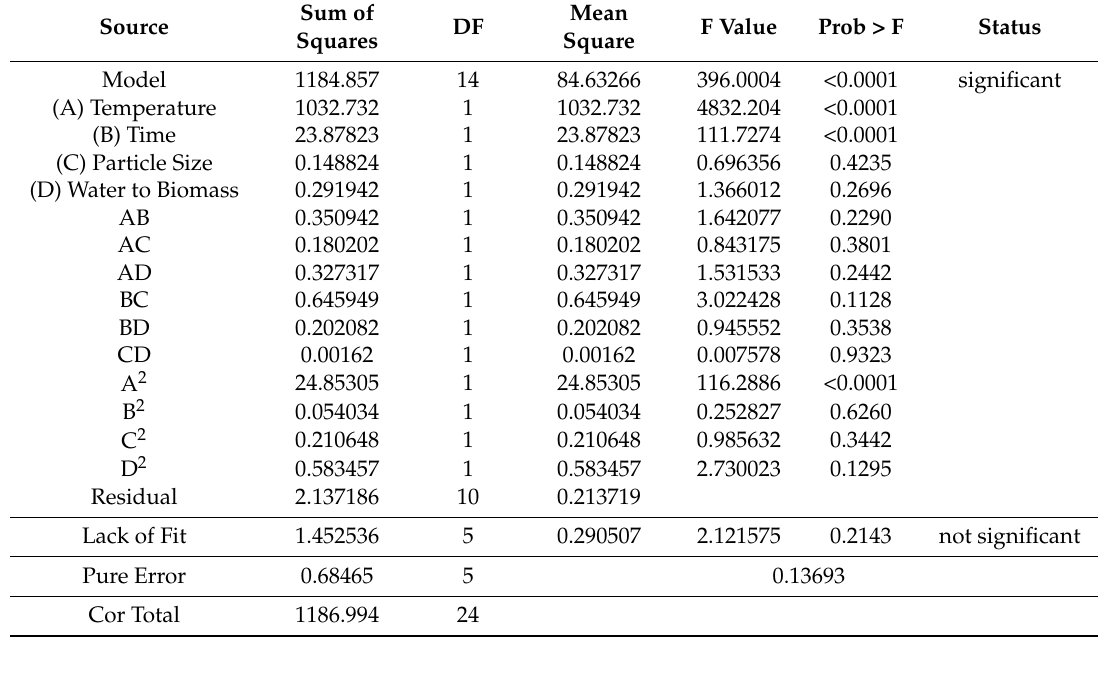
Table 3. The ANOVA for the hydrochar yield % of the MIHTC of rice straw.